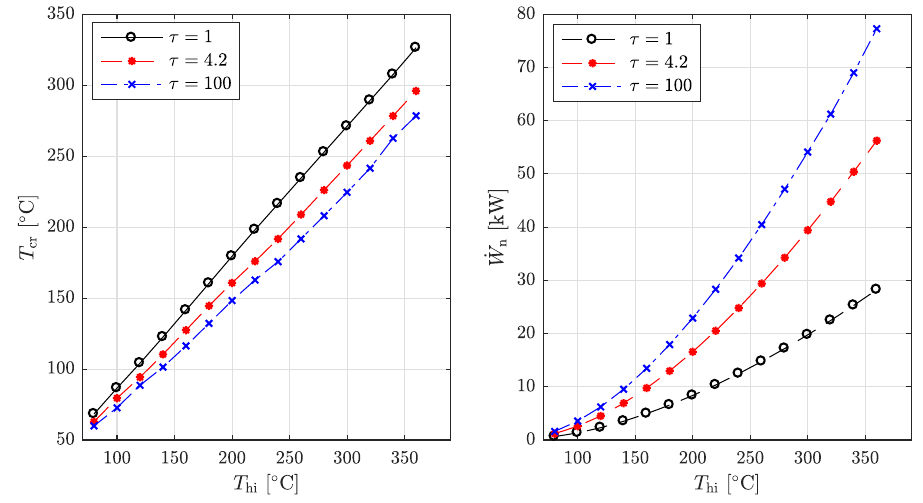
Figure 9. Optimal critical temperature ( left ) and power output ( right ) as a function of heat-source temperature for different heat-capacity ratios ( τ = ( ˙ mc p ) c / ( ˙ mc p ) h ). Results obtained for an unconstrained ( p 1 ≥ 5 kPa) subcritical